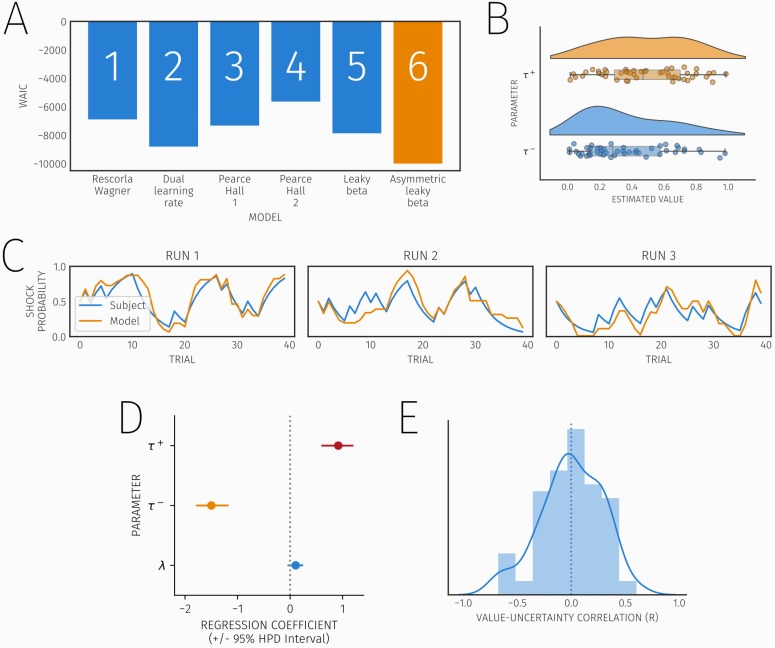
A) Results of model comparison (lower WAIC scores indicate better model fit) demonstrating model fit for the six evaluated models. The best fitting model (6) is shown in orange. B) Estimated values of τ+ and τ-, the parameters governing updates in response to shock and no-shock outcomes respectively, illustrating the bias in updating towards shock outcomes. C) True data and simulated shock probability estimate data from the asymmetric leaky beta model for an exemplar subject over three task blocks. This shows how well the model captures the pattern seen in the data. Blue lines represent the true data, while orange lines represent the simulated data from the model. D) Influence of model parameter values on mean shock probability estimates across subjects, red indicates the effect of τ+, the extent to which subjects update in response to shock outcomes, orange represents τ-, governing updates in response to no-shock outcomes, blue represents λ, the leak rate in the model. E) Histogram of subject-level correlations between value and variance, showing the dissociation between these two factors in the task. The dotted line represents the mean across subjects.